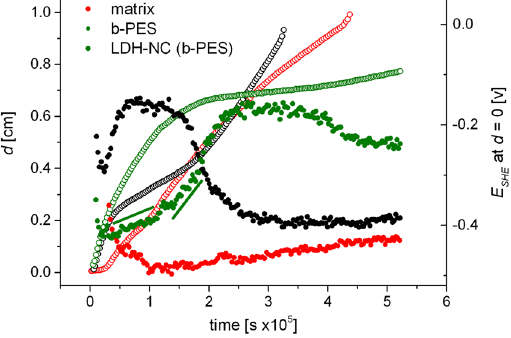
Figure 5. Cathodic delamination of coated steel panels exposed to 0.5 M NaCl. The progress of potential jumps ( d , outlines) and the evolution of the defect potential ( E SHE , solid circles) are